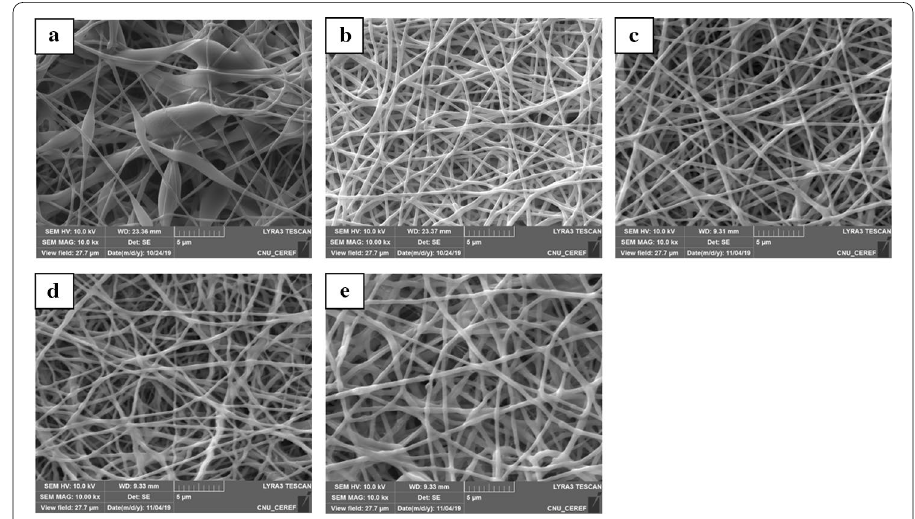
Fig. 3 SEM images of 12% PU/AE nanofibers with different concentrations of AE: a 0 wt%, b 0.5 wt%, c 1 wt%, d 2 wt%, e 3 wt%. (PU solution concentration: 12%, Voltage: 20 kV, TCD:15